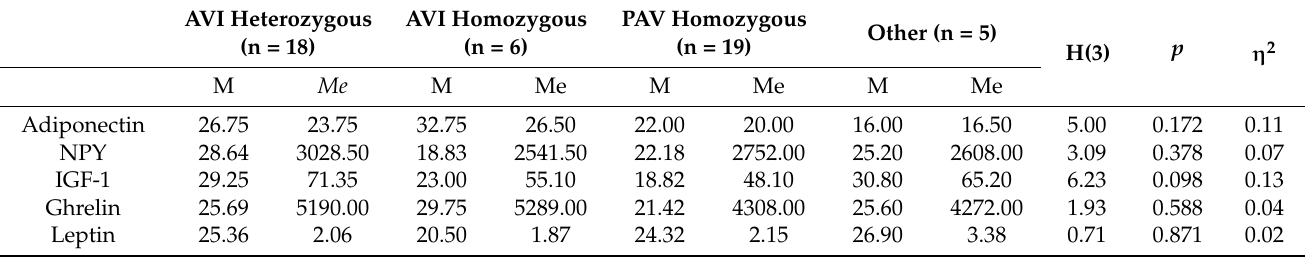
Table 7. Differences in gut-brain hormones and enteric peptides serum levels depending on the bitter taste sensitivity haplotype in prospective